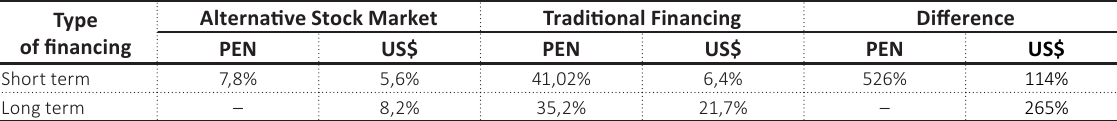
Figure 3. Predisposition to issue and place corporate bonds Table 2. Comparison of average interest rates of the MAV and the traditional